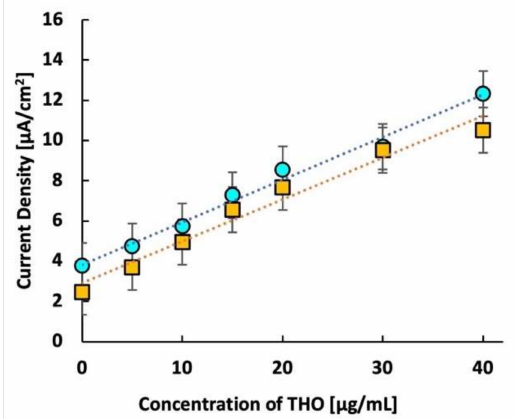
Figure 5. Calibration curve for MIP in buffer saline after 55 days. The circles represent the MIP response on day 1 and the squares represent the response after 55 days of storage at room